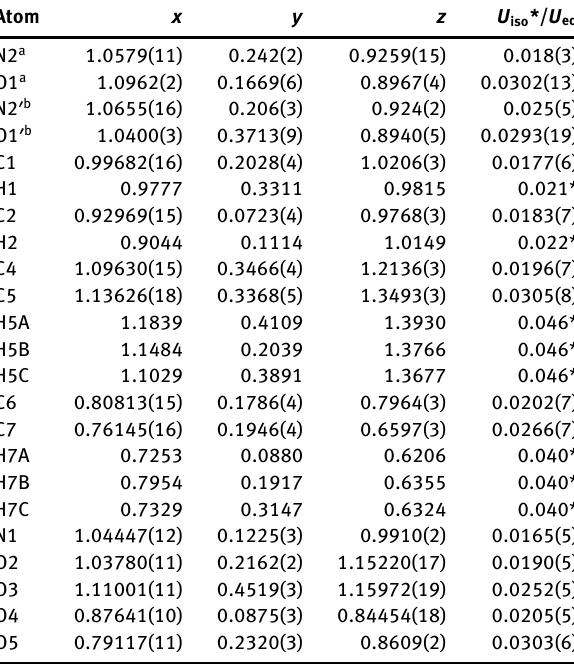
Table 2: Fractional atomic coordinates and isotropic or equivalent isotropic displacement parameters (Å 2